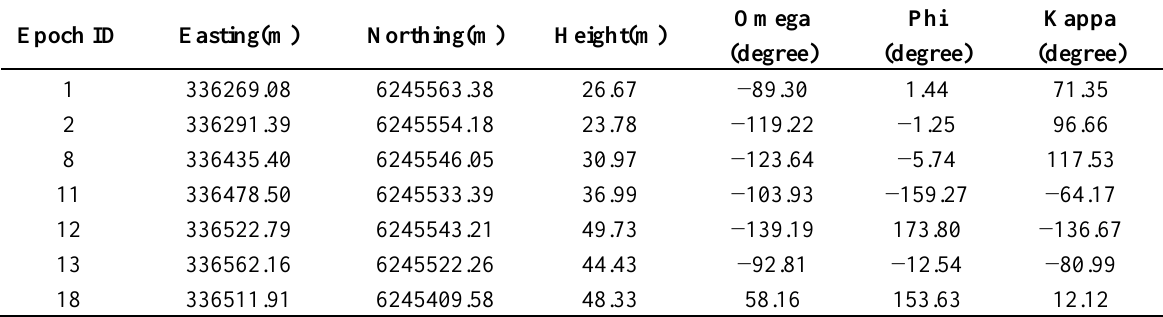
Table 2. System calculated positioning results in 6DoF for the 7 GCPs.